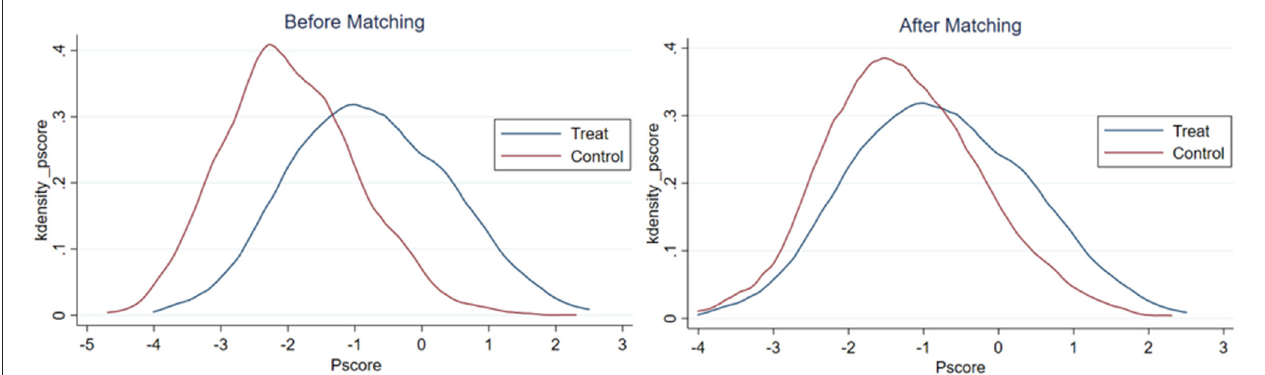
FIGURE 1 | Results of balance hypothesis test: non-agricultural employment as a whole.